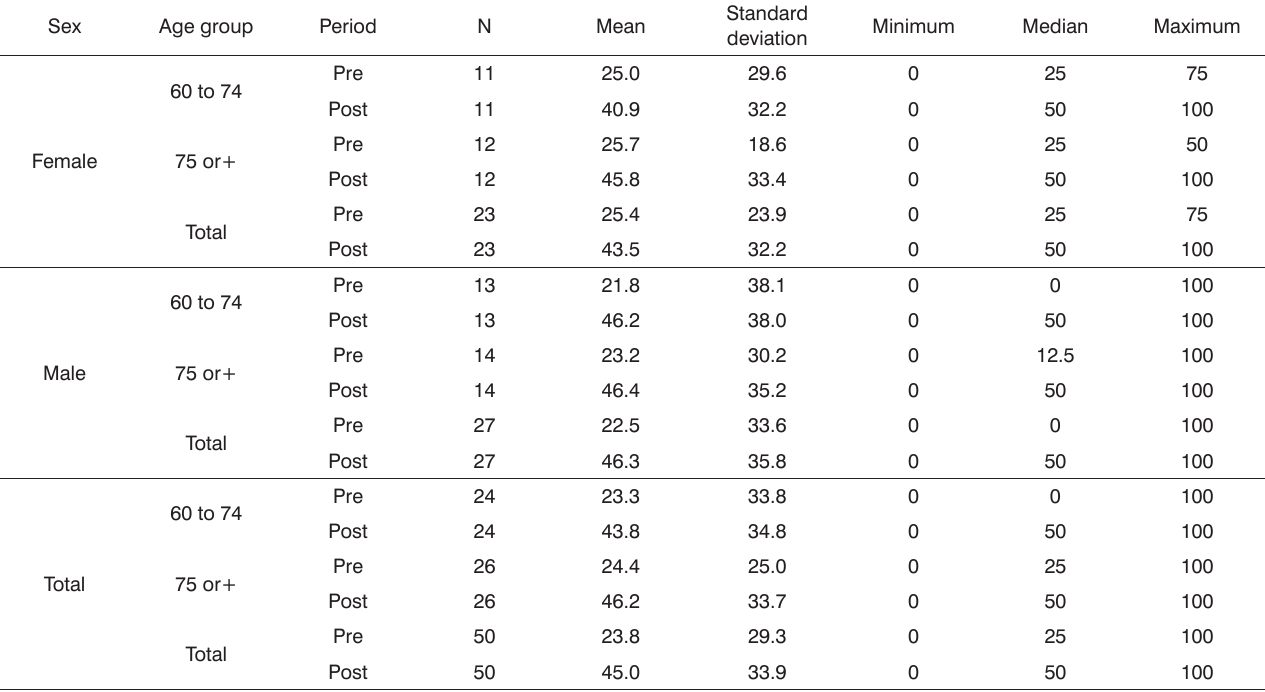
Table 5. Analysis of variance and descriptive statistics for the physical status aspect according to sex and age group. Sex